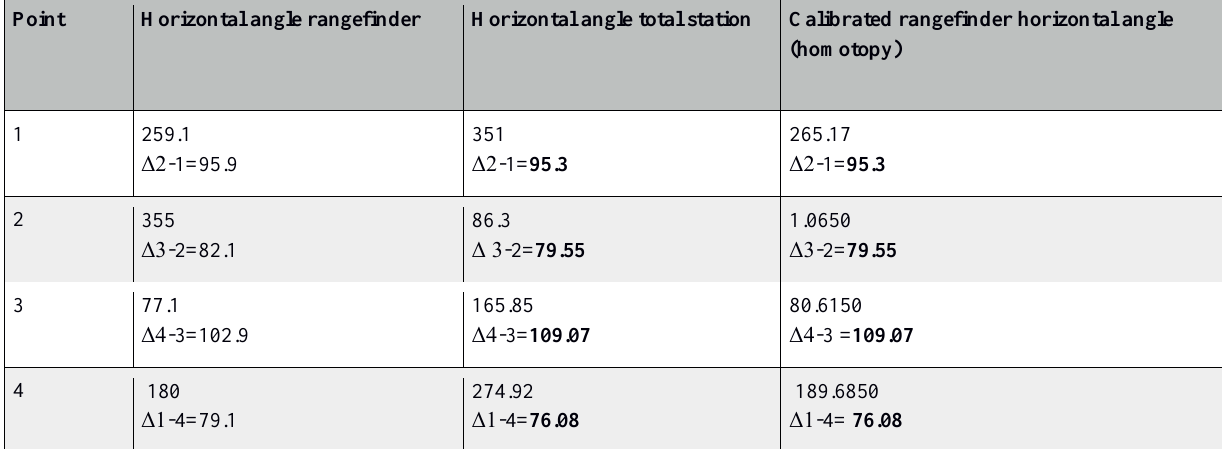
Table 5: Calibration of room 10 rangefinder horizontal angle measurements using total station horizontal angle measurements by homotopies (in decimal degrees).